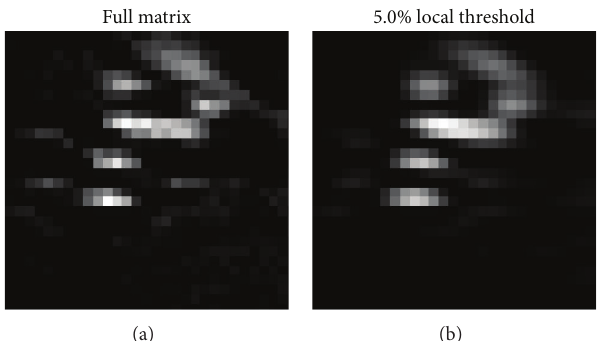
Figure 3: Reconstructed MPI data using the conventional (a) and the sparse (b) reconstruction technique considering a compression rate of 5% and local thresholding.